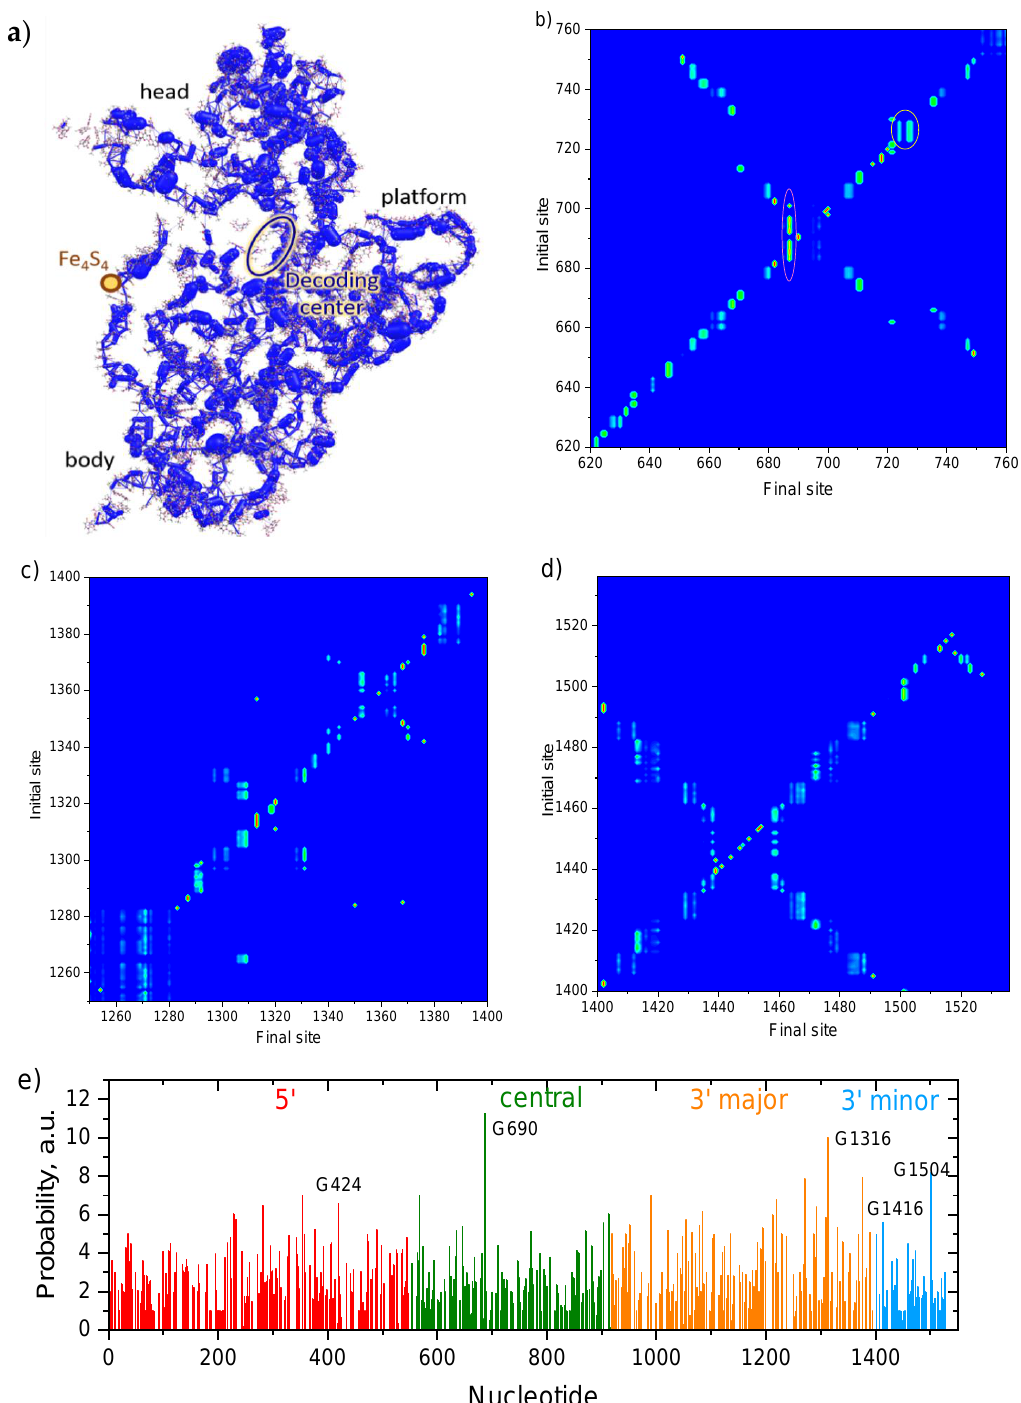
Figure 2. ( a ) Transfer integrals between the nucleotides in SSU. Thicknesses of the cylinders represent the magnitudes of J . ( b – d ) Transition probabilities maps for finding a hole placed at a given initial site at a given final site, in the vicinity of hole scavengers. A deep basin of hole attraction is highlighted with pink circle, a shallow one is highlighted with yellow circle. ( e ) Summarized probability of finding the hole, which started from various initial sites, at the given final site. Simulation time is 100 ns.